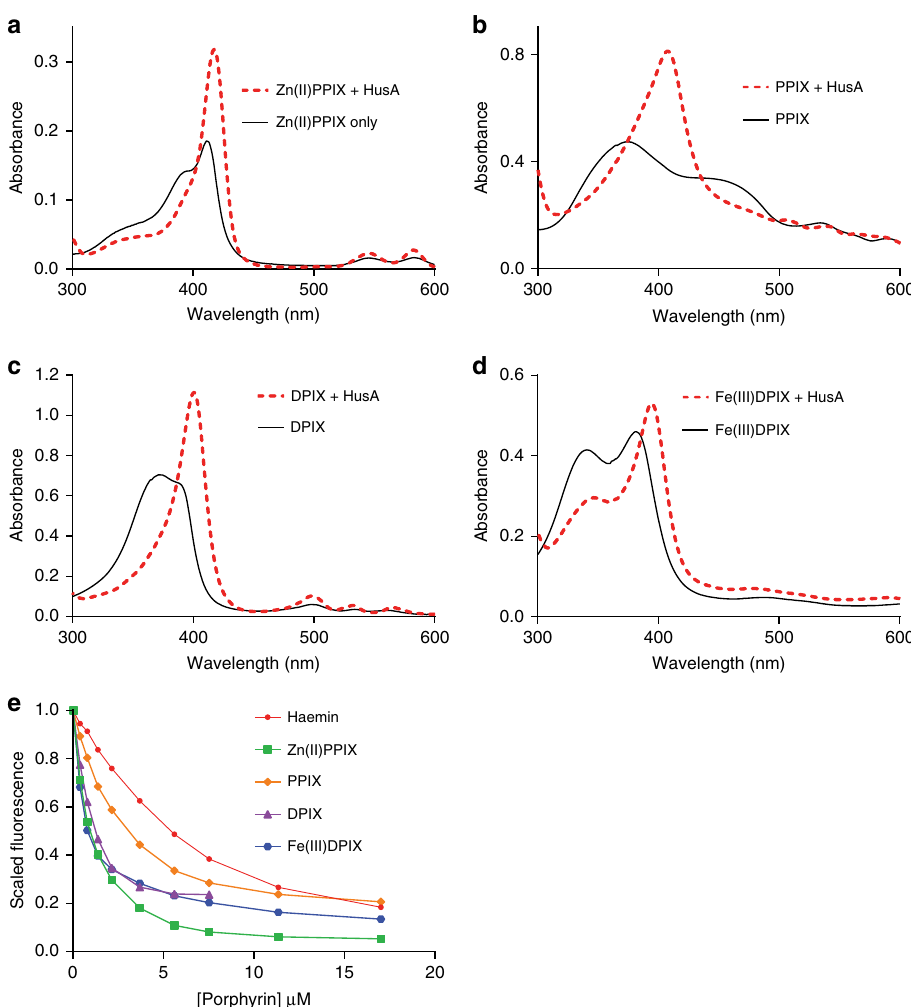
Fig. 4 HusA binds a range of porphyrins, including metallated and unmetallated forms. a – d UV-visible spectra of 10 − 20 μ M of ZnPPIX, PPIX, DPIX and haemin, alone and in the presence of 1 – 1.5 molar equivalents of HusA. e Scaled and corrected fl uorescence intensities at 335 nm during titration of 1 μ M of HusA with increasing concentrations of haemin and other porphyrins. Fitting to a 1:1 binding model yielded the dissociation equilibrium constants